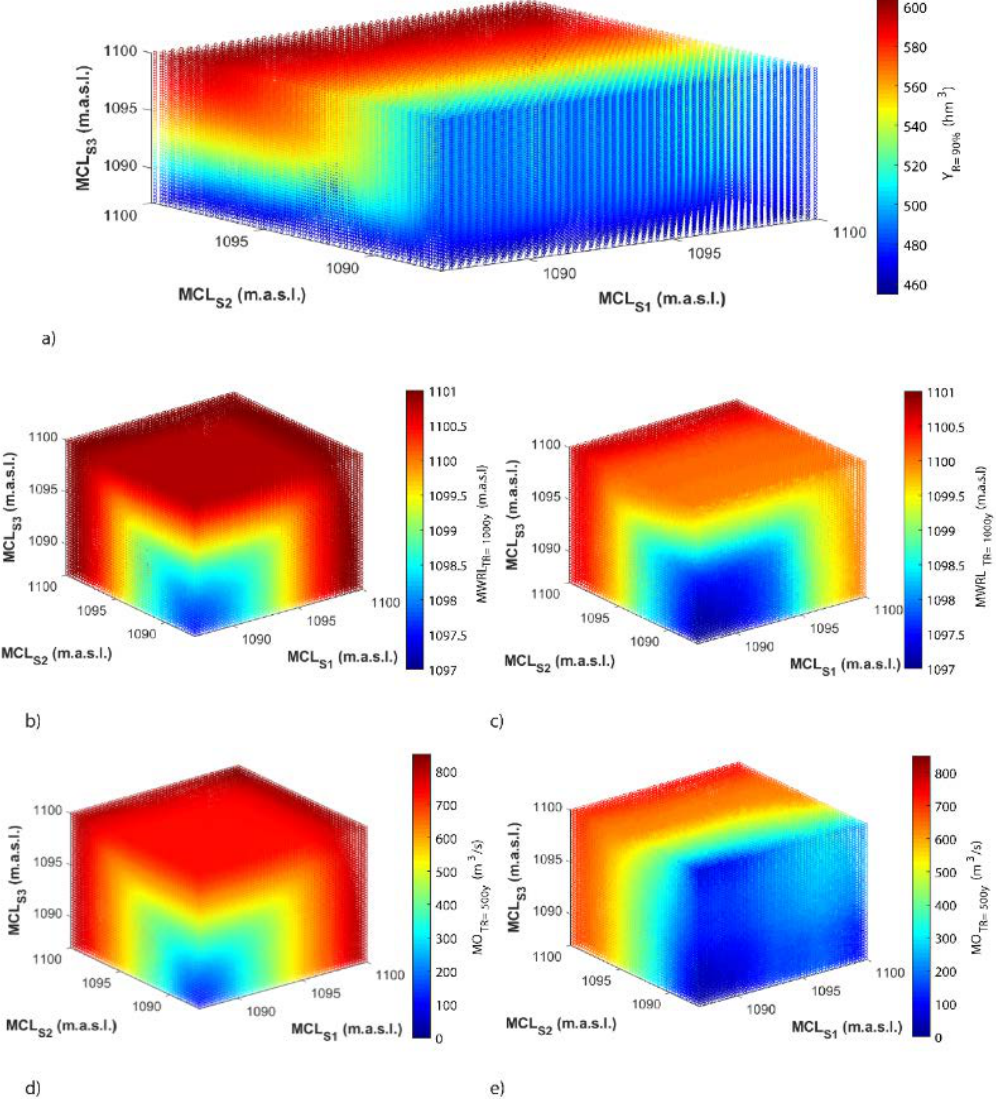
Figure 5. Representations of the 132,651 values of MWRL TR = 1000y , MO TR = 500y , and Y R = 90% for each of the seasons (S1, S2, and S3). MCL S1 , MCL S2 , and MCL S3 represent the maximum conservation levels in S1, S2, and S3 respectively. ( a ) Representation of the values Y R = 90% , with a color bar, which are the same in Sc.1 (initial reservoir level equal to MCL) and Sc.2 (variable initial reservoir level). ( b , c ) Representation of the values MWRL TR = 1000y with a color bar in Sc.1 ( b ) and Sc.2 ( c ). ( d , e ) Representation of the values MO TR = 500y with a color bar in Sc.1 ( d ) and Sc.2 ( e ).